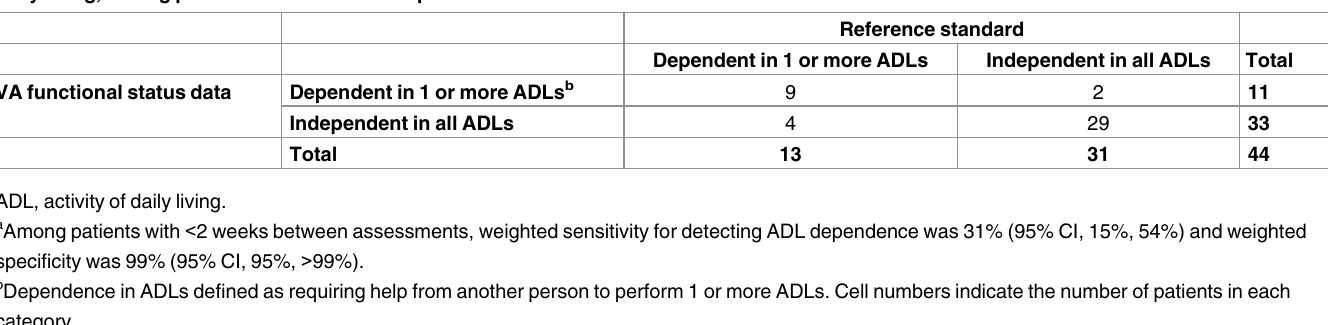
Table 6. Agreement of VA functional status data with the referencestandard of research-collected data for assessing dependence in activities of daily living, among patients with < 2 weeks elapsed between assessments.